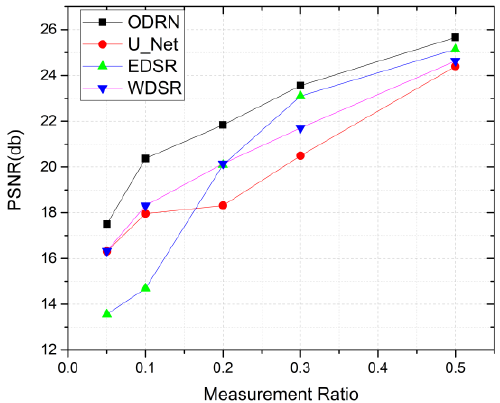
Figure 7. PSNR values of DPAP imaging results when using different DIP reconstruction networks. Table 1. PSNR of reconstruction results at different measurement rates when DPAP uses different DIP reconstruction networks.